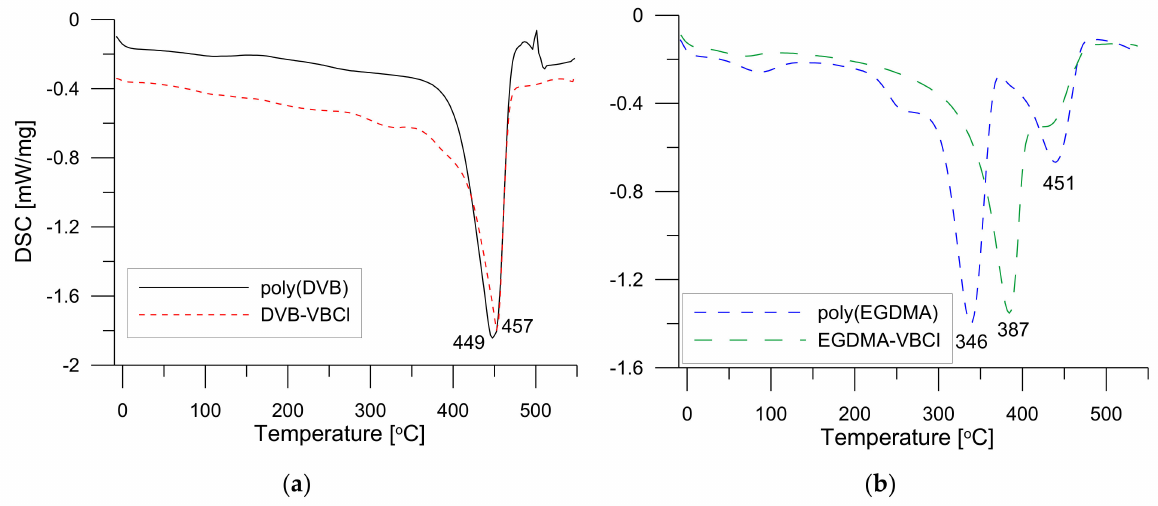
Figure 5. DSC curves of ( a ) poly(DVB) and DVB-VBCl as well as ( b ) poly(EGDMA) and